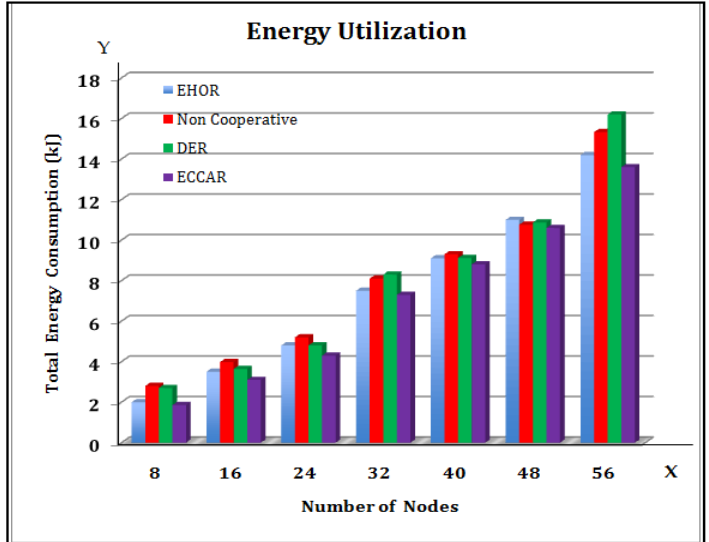
Figure 3. Overall Energy